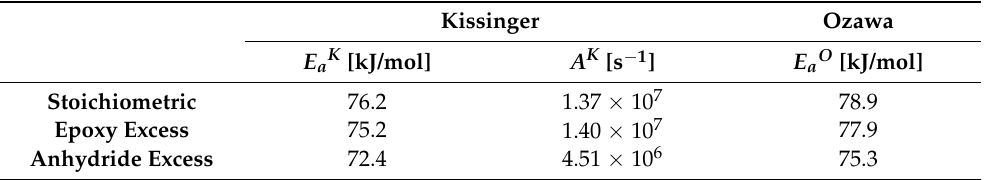
Figure 2. Plots of the heating rate versus 1/ T p . Dash lines represent the linear fit according to ( a ) Kissinger (Equation (11)) and ( b ) Ozawa (Equation (13)). Table 2. Values of the global activation energy ( E aK ) and the preexponential factor ( A K ) determined by the Kissinger method and the global activation energy ( E aO ) determined by the Ozawa method.